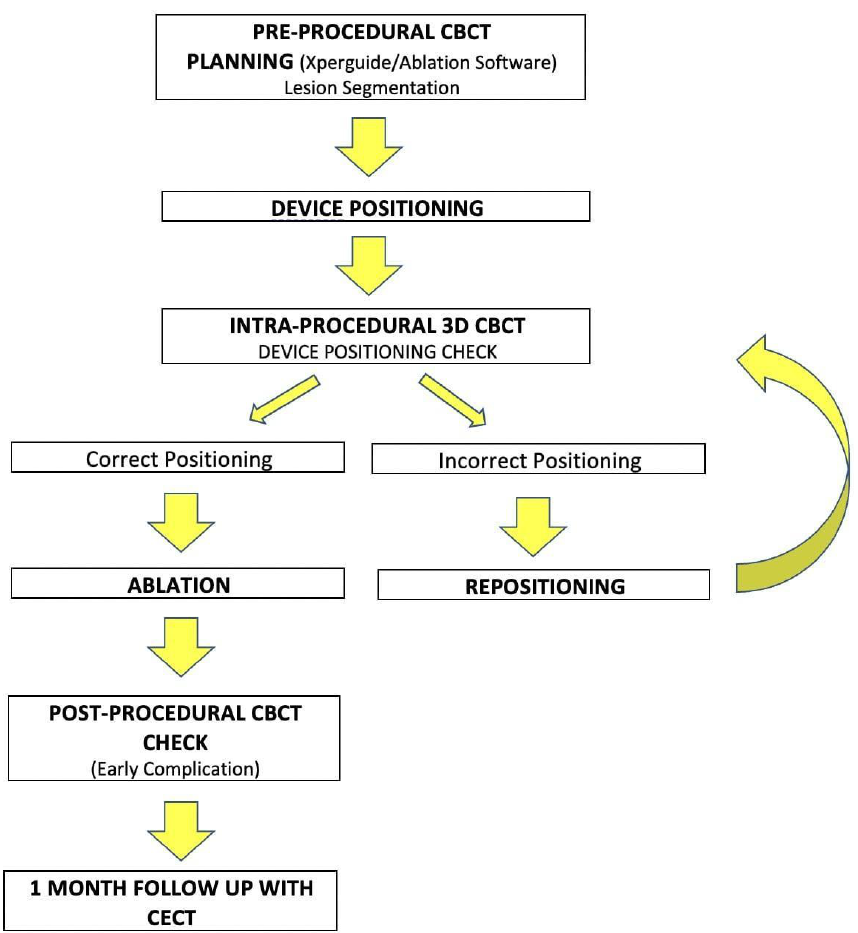
Figure 3. Workflow from pre-procedural CBCT planning to 1-month follow-up CECT [16]. Reproduced with the permission from Anna Maria Ierardi, Acta Radiologica, published by SAGE, 2016.